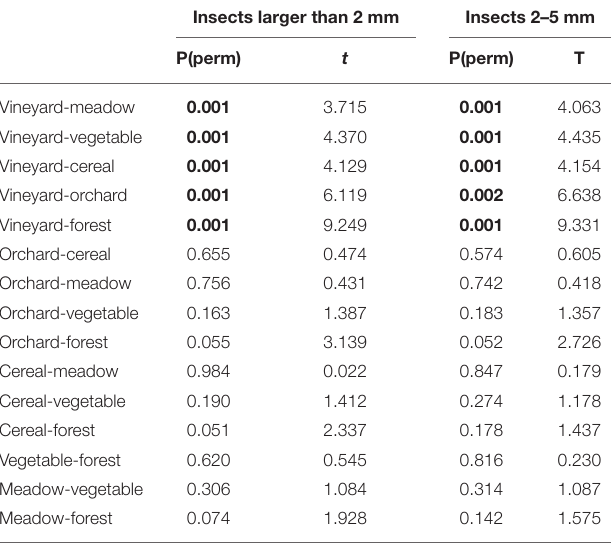
TABLE 4 | Results of pairwise comparisons (PERMANOVA) of numbers of nocturnal insects (insects larger than 2mm; insects sized between 2 and 5mm) between the different habitats (forest, meadow, vineyard, orchard, vegetable,